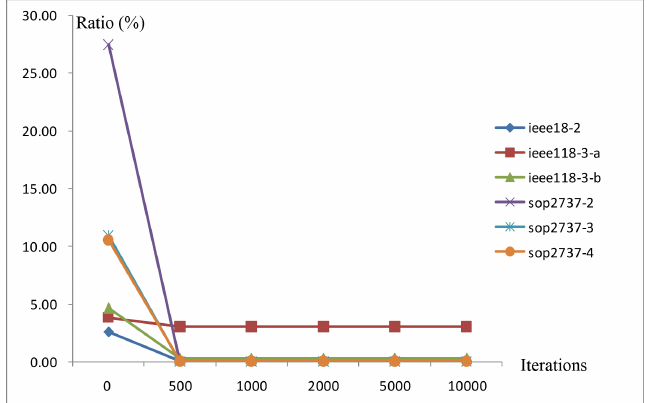
Figure 10. The convergence curves of the first six instances generated by the algorithm with L = 7 .